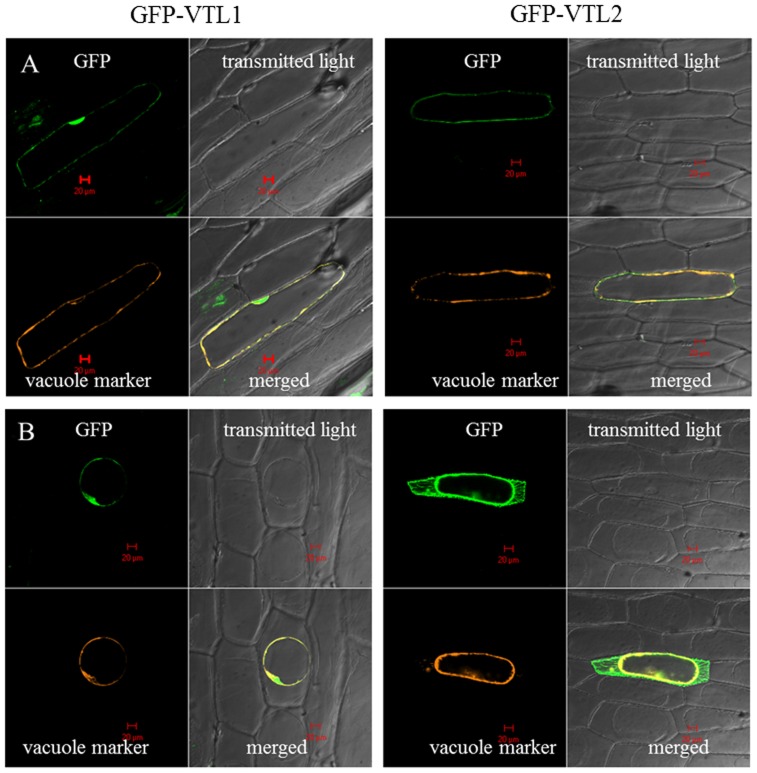
Transient 35S:GFP::VTL1 and 35S:GFP::VTL2 expression in onion epidermis cells.The GFP-VTL1 fluorescent signal co-localized with the vacuolar marker, vac-rk CD3-975, in turgescent (A) and plasmolyzed (B) cells. The GFP-VTL2 signal was also observed on the plasma membrane and cytoplasma (B).